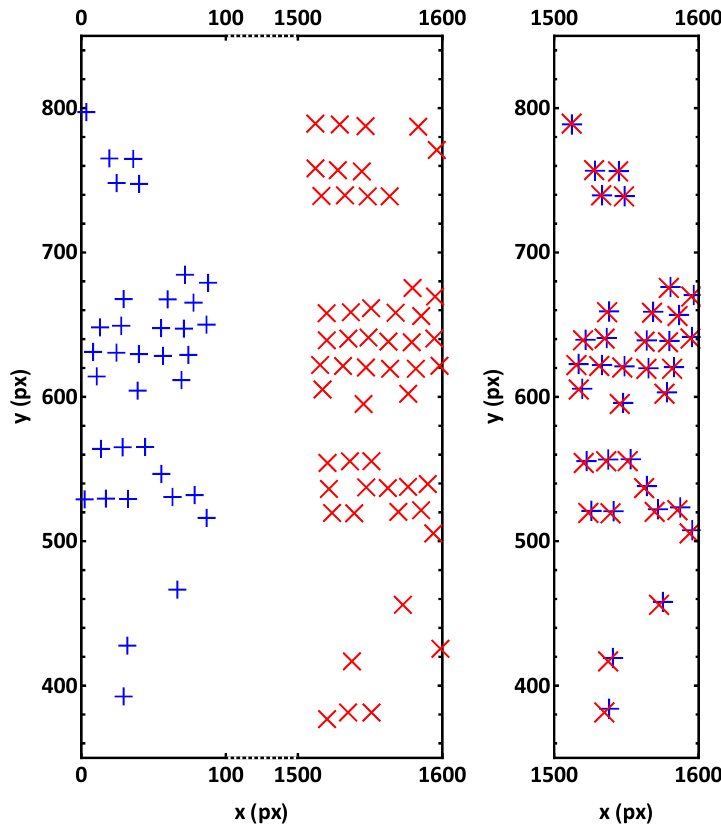
Figure 9. ( Left ) All detected particle coordinates in the overlap region in one image pair recorded by both cameras are shown (all coordinates in the coordinate system of the respective camera). Some coordinates from the left image (red crosses) do not have an associated coordinate in the right image (blue plus signs), and vice versa. ( Right ) The approximate translations, t ax = 1508.8 px and t ay = − 8.5 px, were used to transform the coordinates of particles with detected partners from the coordinate system of Camera 2 to that of Camera 1 (red crosses and blue plus signs at approximately the same position). Non-associated coordinates (particles seen only by one camera) were